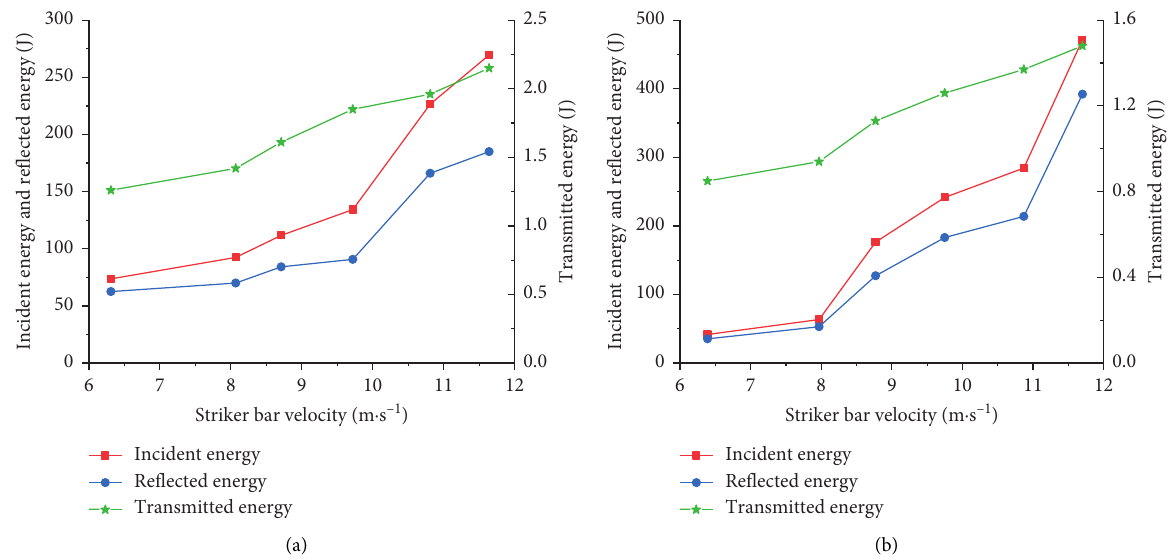
Figure 10: Relationship between stress wave energy and impact velocity. (a) Rockburst-prone coal samples. (b) Nonprone coal